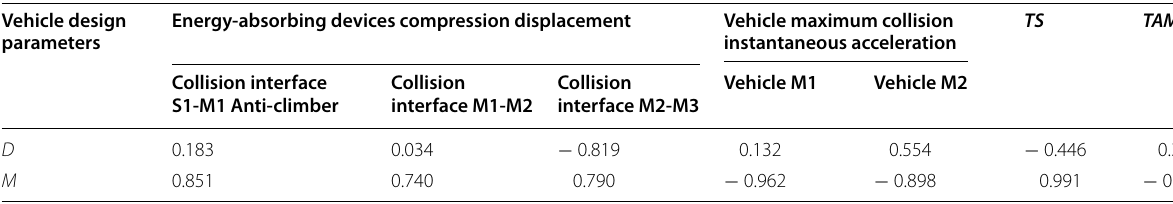
Table 10 Correlation coefficient matrix Vehicle design